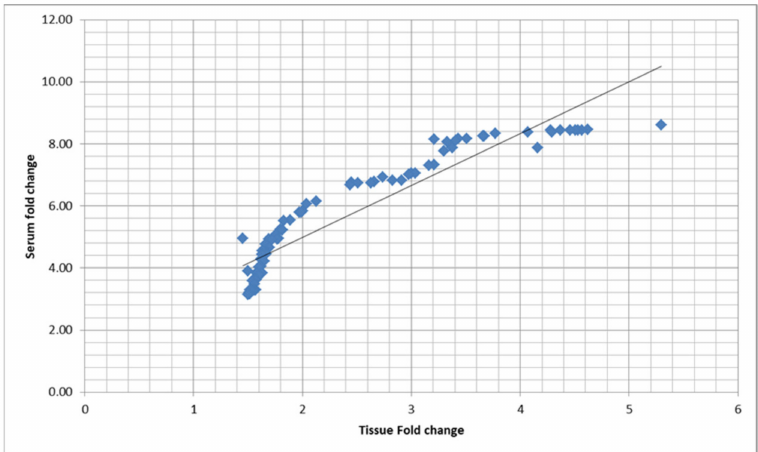
Figure 2. Correlation between serum and tissue expression of piR-823 measured in fold change. The curve shows a strong positive correlation with a correlation coefficient of 0.9285, p <